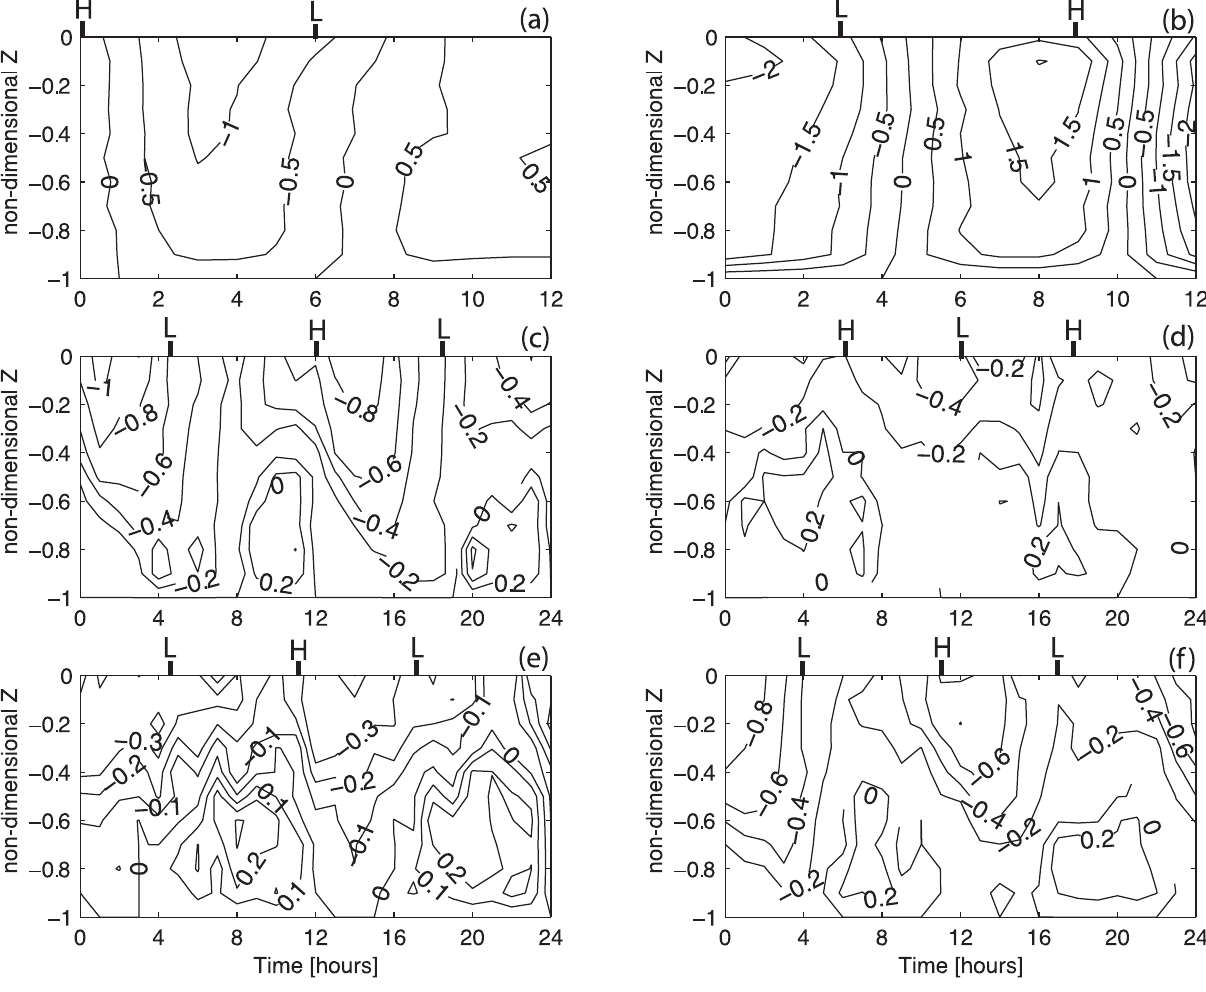
Figure 3. Contour figures of longitudinal velocity component as a function of the depth (Z) and time for all survey periods. H and L indicate the local high and low-water. (a) 21/02/2002 (station A); (b) 28/02/2002 (station A); (c) 15/01/2004 (station B); (d) 16/06/2004 (station B); (e) 27/08/2004 (station B); (f) 03/12/2004 (station B).